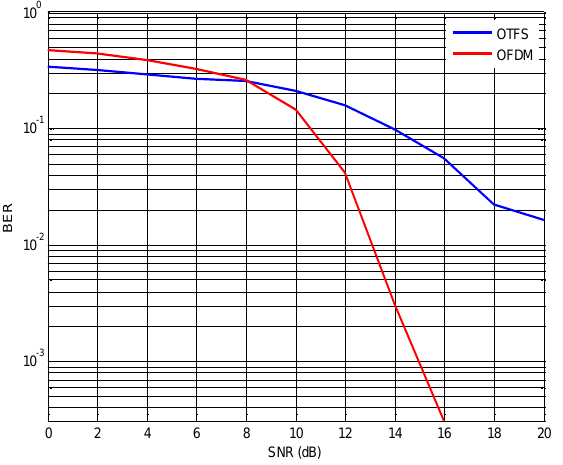
Figure 5: BER Vs SNR for OFDM (number of subcarriers M=64) and OTFS (number of subcarriers M=8) with 16-